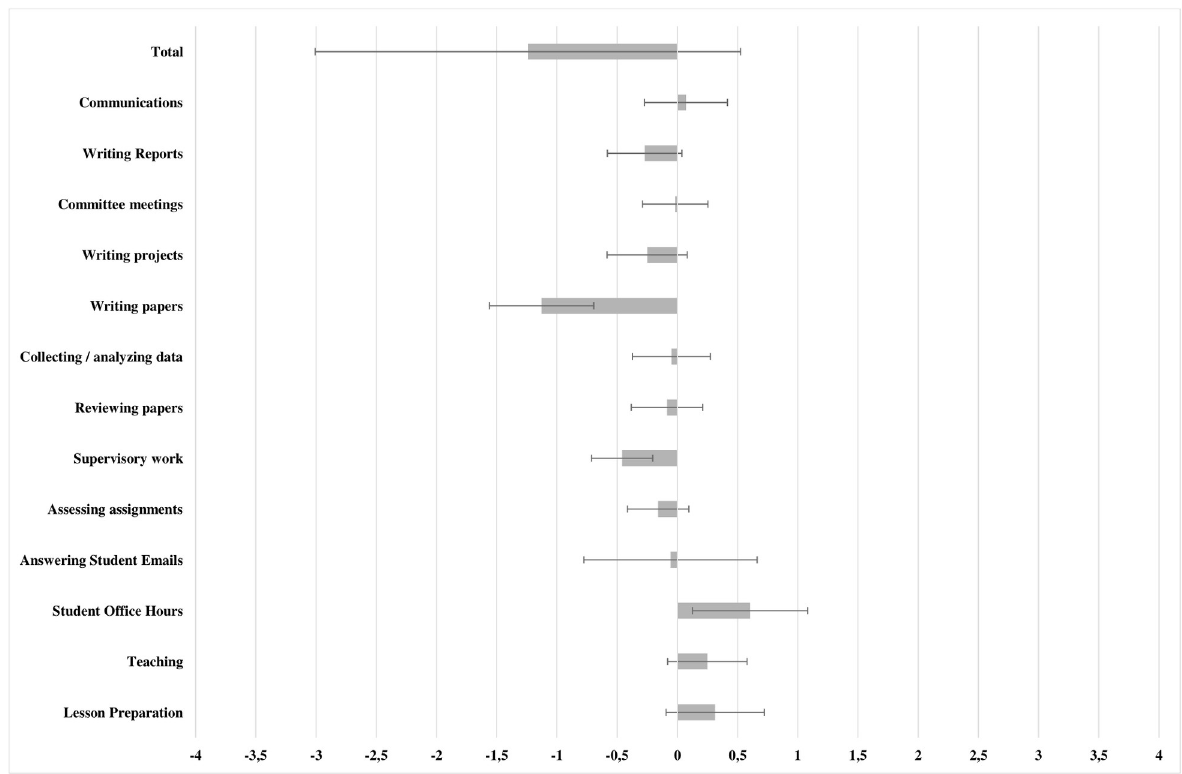
Fig 3. Differences between observed and expected changes in working hours in the second pandemic semester, relative to the previous semester. Error bars indicate 95% confidence intervals.